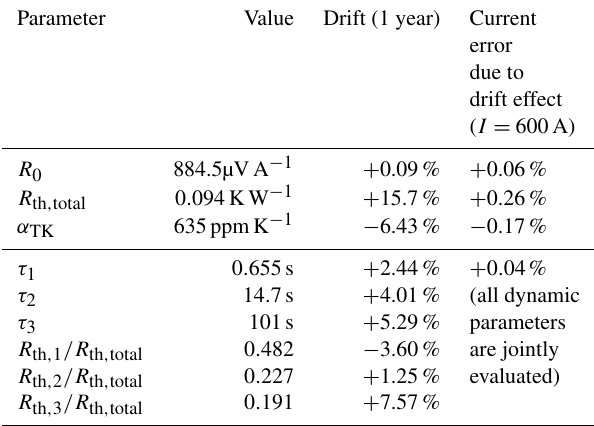
Table 7. Parameter drift of a single shunt after operation for 1 year. The total charge throughput during this time was approximately